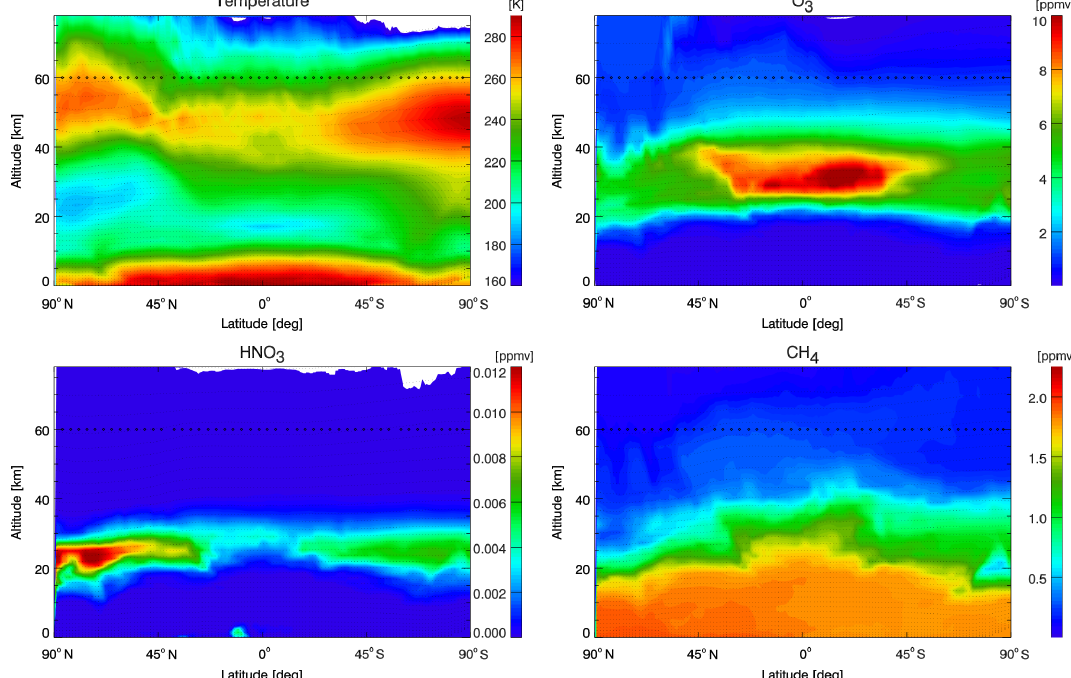
Figure 1. Temperature, O 3 , HNO 3 and CH 4 distributions from EMAC model simulations for 21 December 2011 as a function of altitude and latitude (90 ◦ N–90 ◦ S) along MIPAS orbit 51301. The small black dots represent EMAC altitude–latitude grid, while black diamonds represent the latitudinal position of MIPAS scans in this